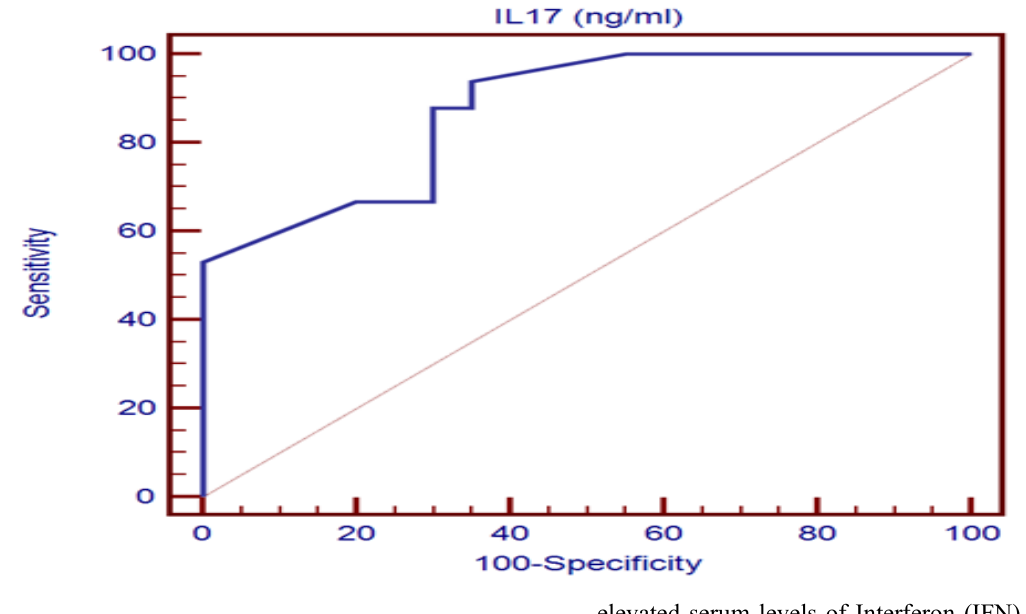
Figure 1. ROC curve of serum IL-17 as a predictor of COVID 19